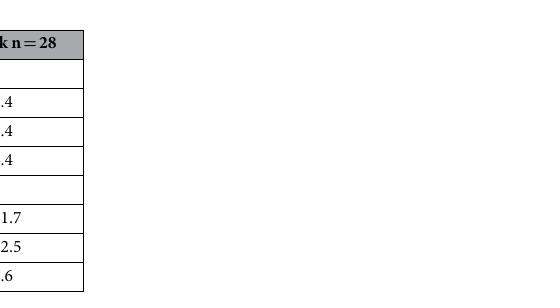
Table 3. Heart Rate and Mean Arterial Pressure. Data are presented as mean ± standard